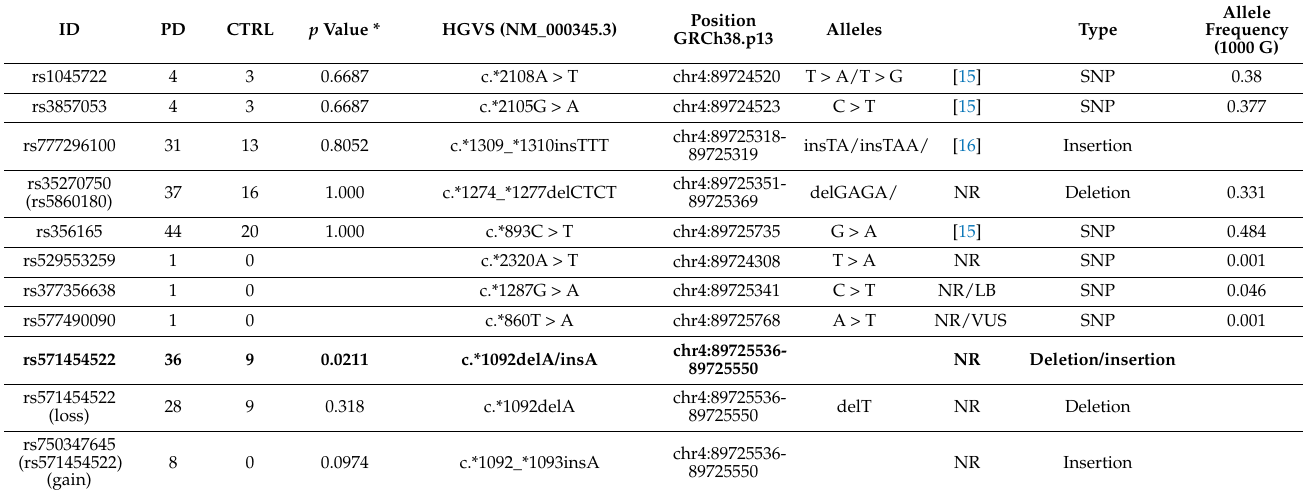
Table 2. Identified variants in the 3 (cid:48) UTR region of SNCA gene.